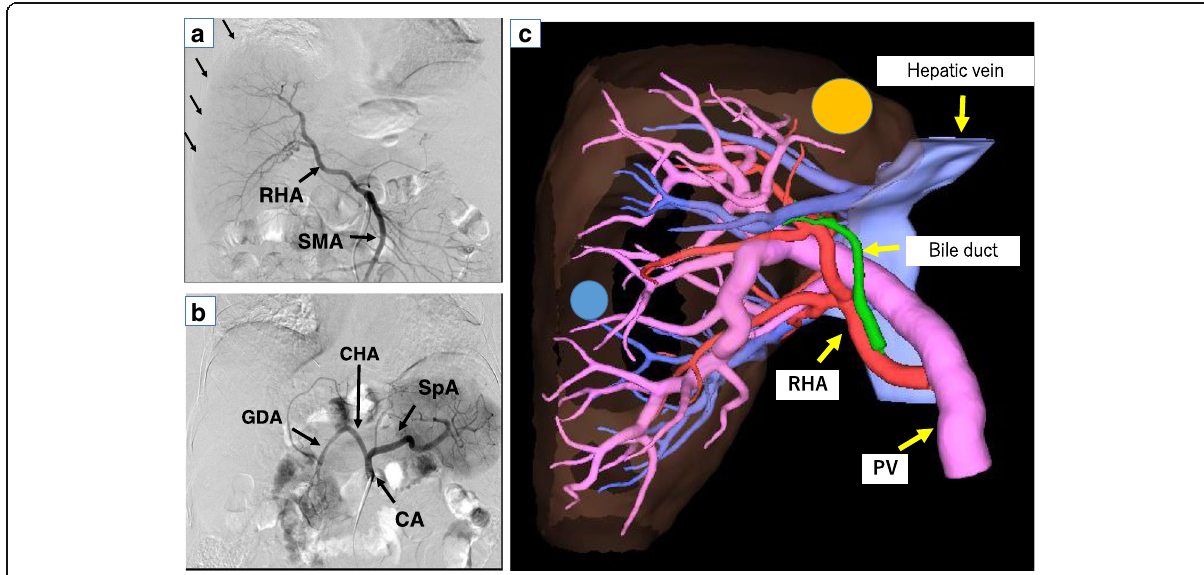
Fig. 3 Abdominal angiography and MPR images show agenesis of the left hepatic lobe. a Superior mesenteric arteriography shows the right hepatic lobe was visualized. b Celiac arteriography shows no region of the liver was visualized. c MPR image shows the absence of the left